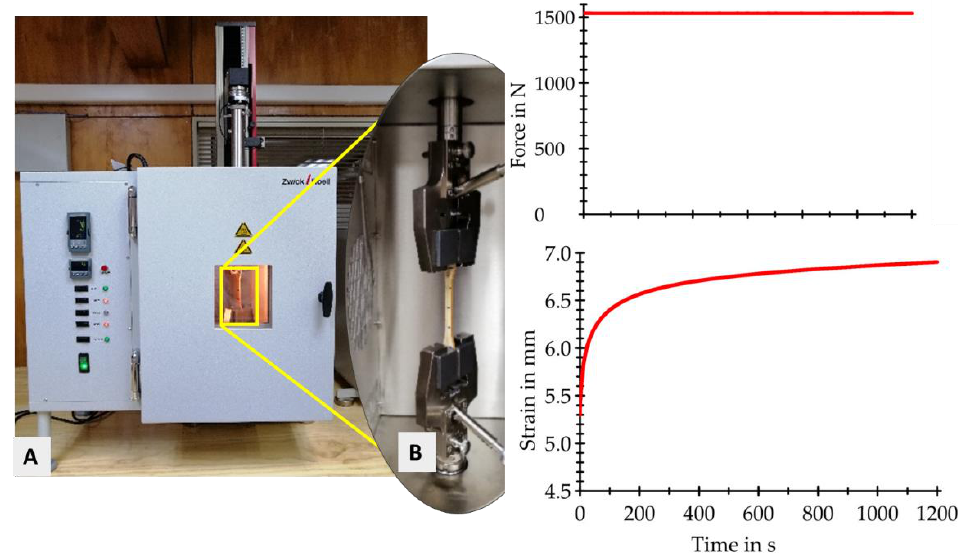
Figure 3. Tensile creep test: ( A ) testing machine equipped with temperature chamber; ( B ) specimen during tensile creep test.